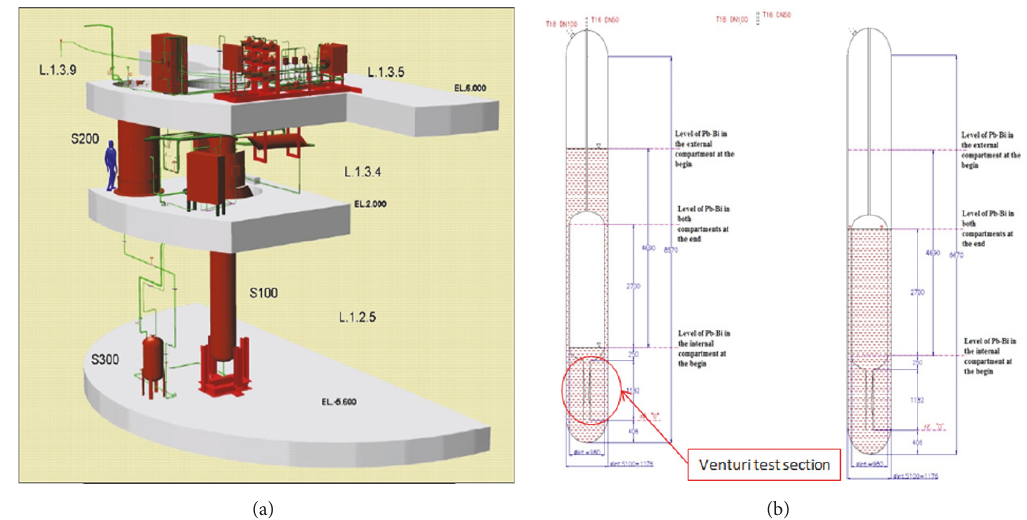
Figure 1: (a) CIRCE facility plant layout and (b) schematic representation of the tank with the indication of the Venturi test section